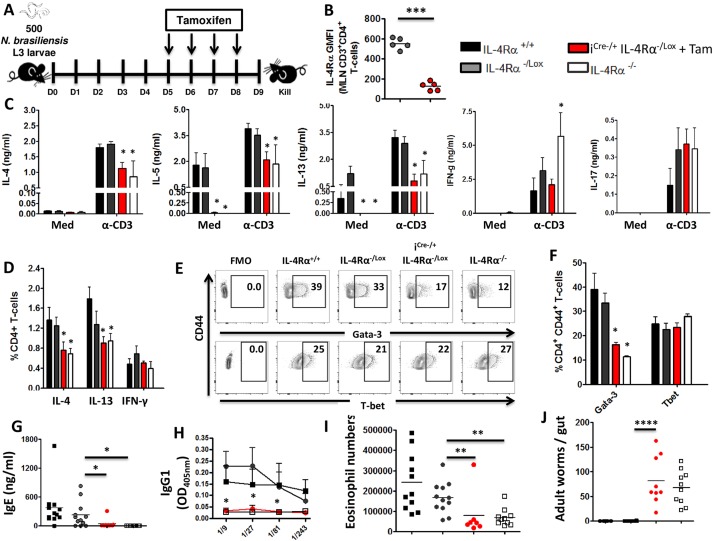
Sustained IL-4Rα mediated signaling is critical for the anti-parasitic type 2 immune responses during primary N. brasiliensis infection.Mice were infected with 500 L3 N. brasiliensis, fed with tamoxifen once daily from day 5 to day 8 post infection and killed 9 days post-infection. A. Schematic showing the experimental design. B. IL-4Rα expression on CD3+CD4+ T-cells from MLN of N. brasiliensis-infected mice. C. Cytokine production detected by ELISA in the supernatant of restimulated MLN cells. D. Percentages of cytokine-producing CD4+ T-cells after stimulation with PMA/Ionomycin/Monensin cocktail. E. Percentages of transcription factor-expressing CD3+CD4+ T-cells (ex-vivo) summarized in (F). G. Total serum IgE in N. brasiliensis-infected mice. H. NbAg-specific serum type 2 antibodies. I. Eosinophil (SiglecFhi) numbers per MLN. J. Worm counts per gut. Each experiment was conducted at least twice with 4–12 mice per group. Data are expressed as mean ± SD; NS = p > 0.05; * = p < 0.05; ** = p < 0.01; *** =, p < 0.001; **** = p < 0.0001.